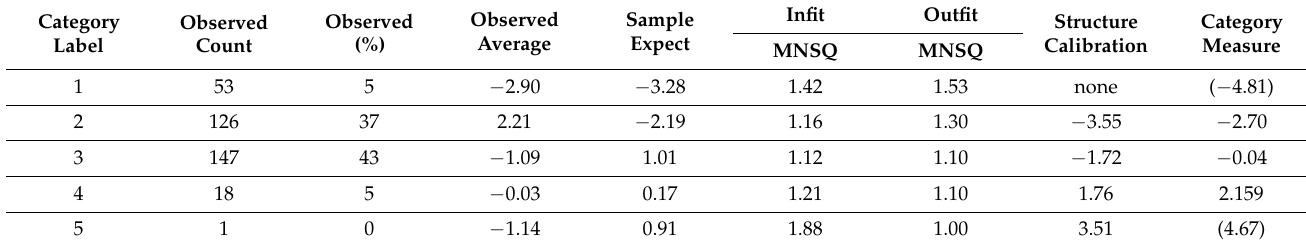
Table 4. Calibration scaling analysis. Table 4 . Calibration scaling analysis .